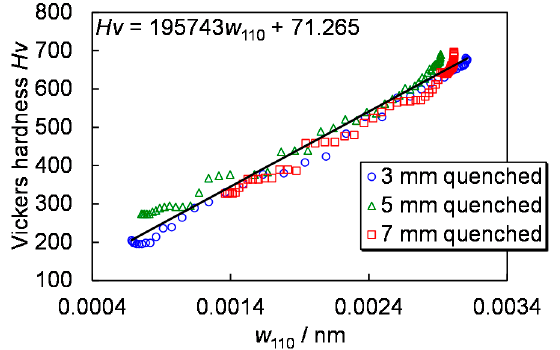
Figure 14. Relation between the Vickers hardness and FWHM of d -spacing distribution, discovered by Bragg-edge neutron transmission imaging [6].